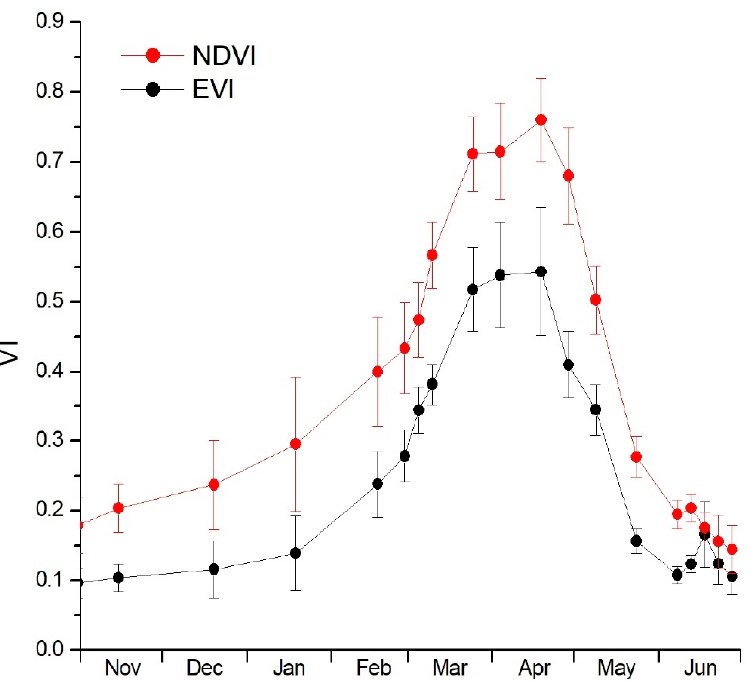
Figure 5. Seasonal fluctuation of Sentinel-2 vegetation indices (NDVI and EVI). Data are means from six plots (9 pixels per plot) ± standard deviation.